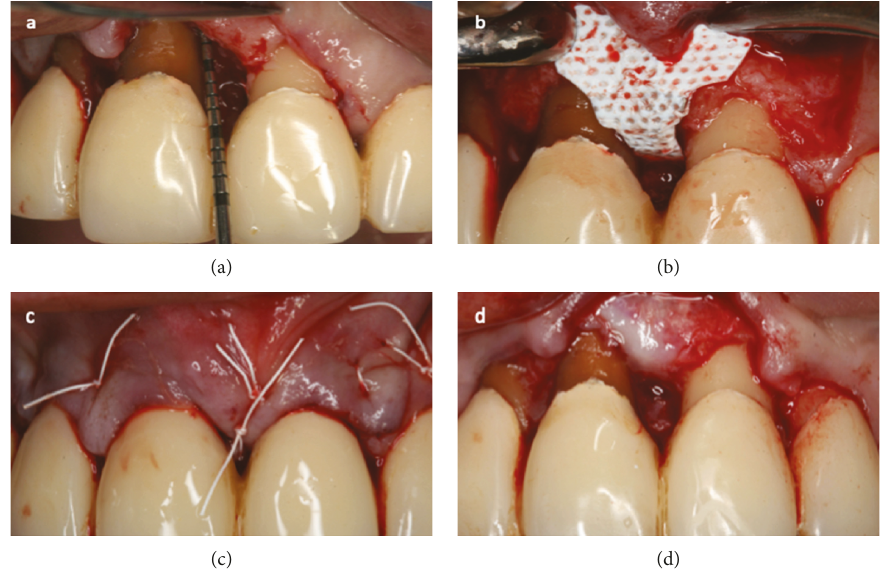
Figure 2: In the sites with intrabony periodontal component, after fl ap elevation, the granulation tissue was removed and roots were planned (a). The defect was covered with nonresorbable titanium-reinforced completely inert membrane (dense polytetra fl uoroethylene) alone with no bone substitutes (b) and closed with a single-modi fi ed internal mattress suture (c). The membrane was removed 6 weeks after surgery